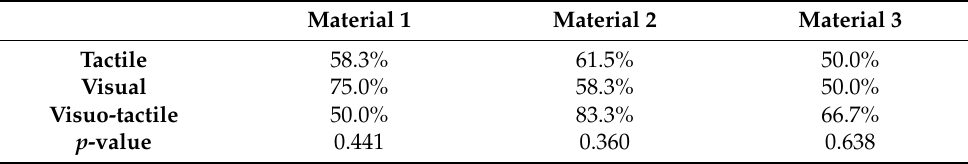
Table 2. Identification accuracy for each material, with the results of a Chi-Square test for detecting statistically significant differences among materials.